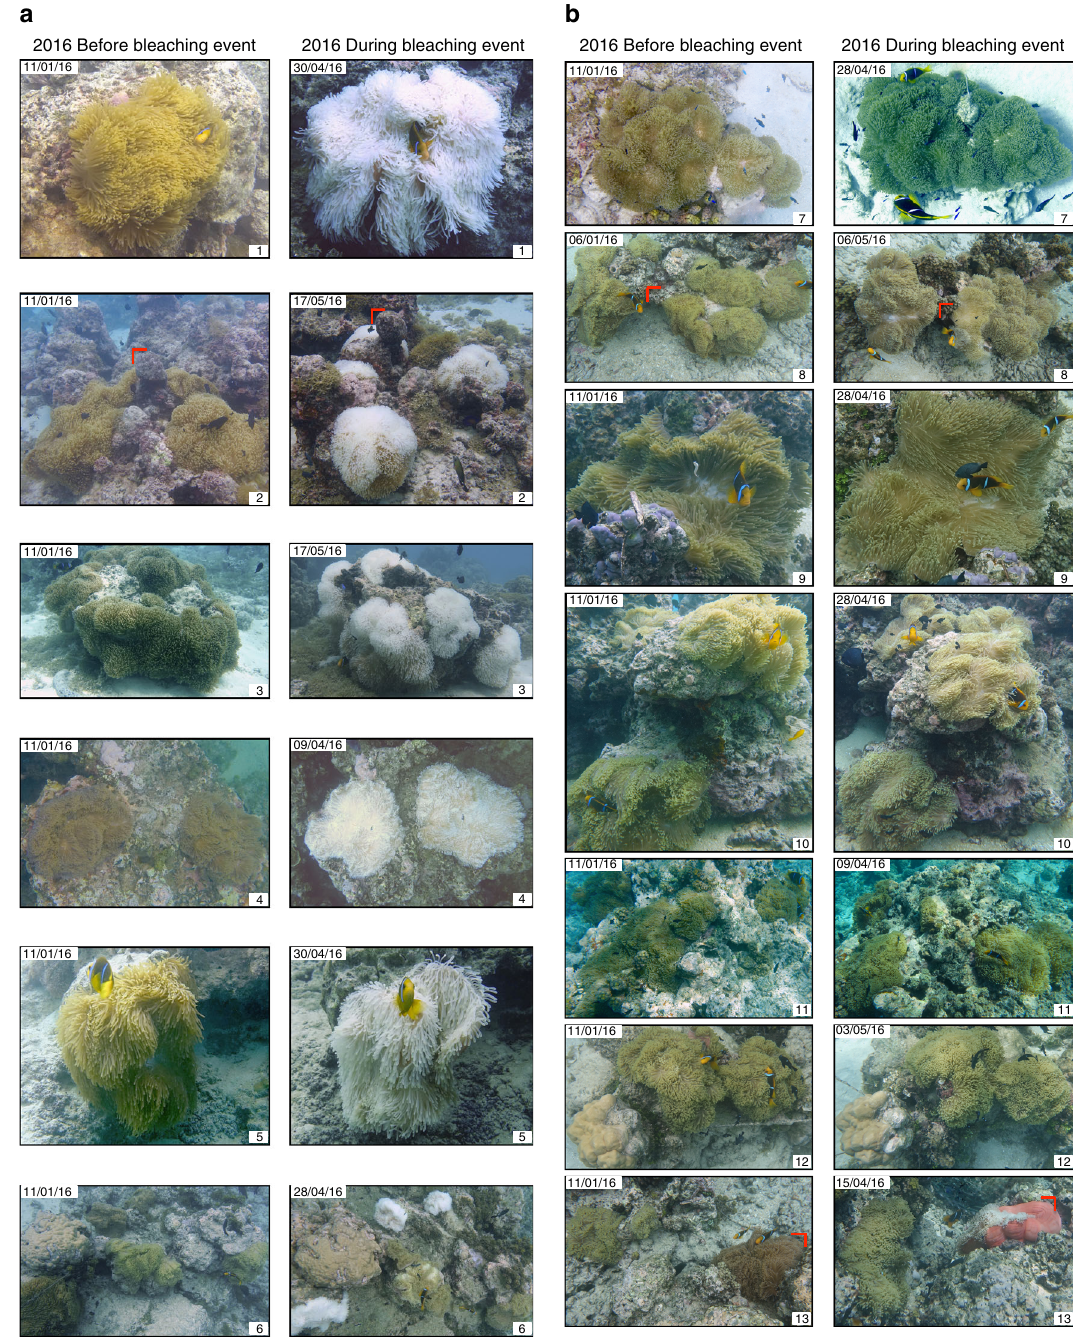
Fig. 2 Photographs of the 13 anemone H. magni fi ca taken prior to bleaching in January 2016 and during bleaching from April to May 2016. a Shows those anemones that bleached and b shows those anemones that did not bleach following the warming event in March